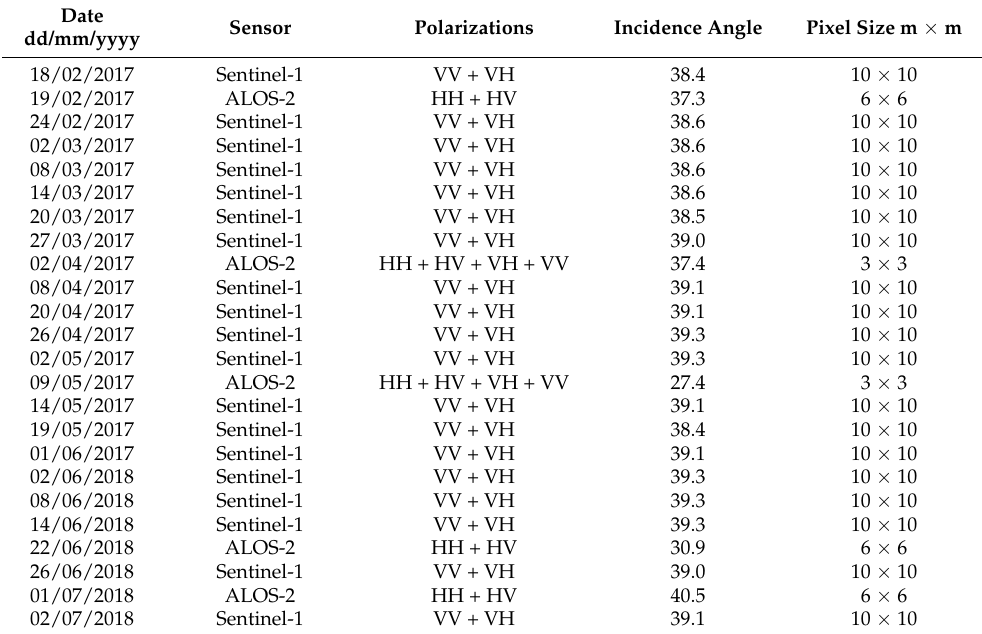
Table 1. Characteristics and acquisition dates of SAR